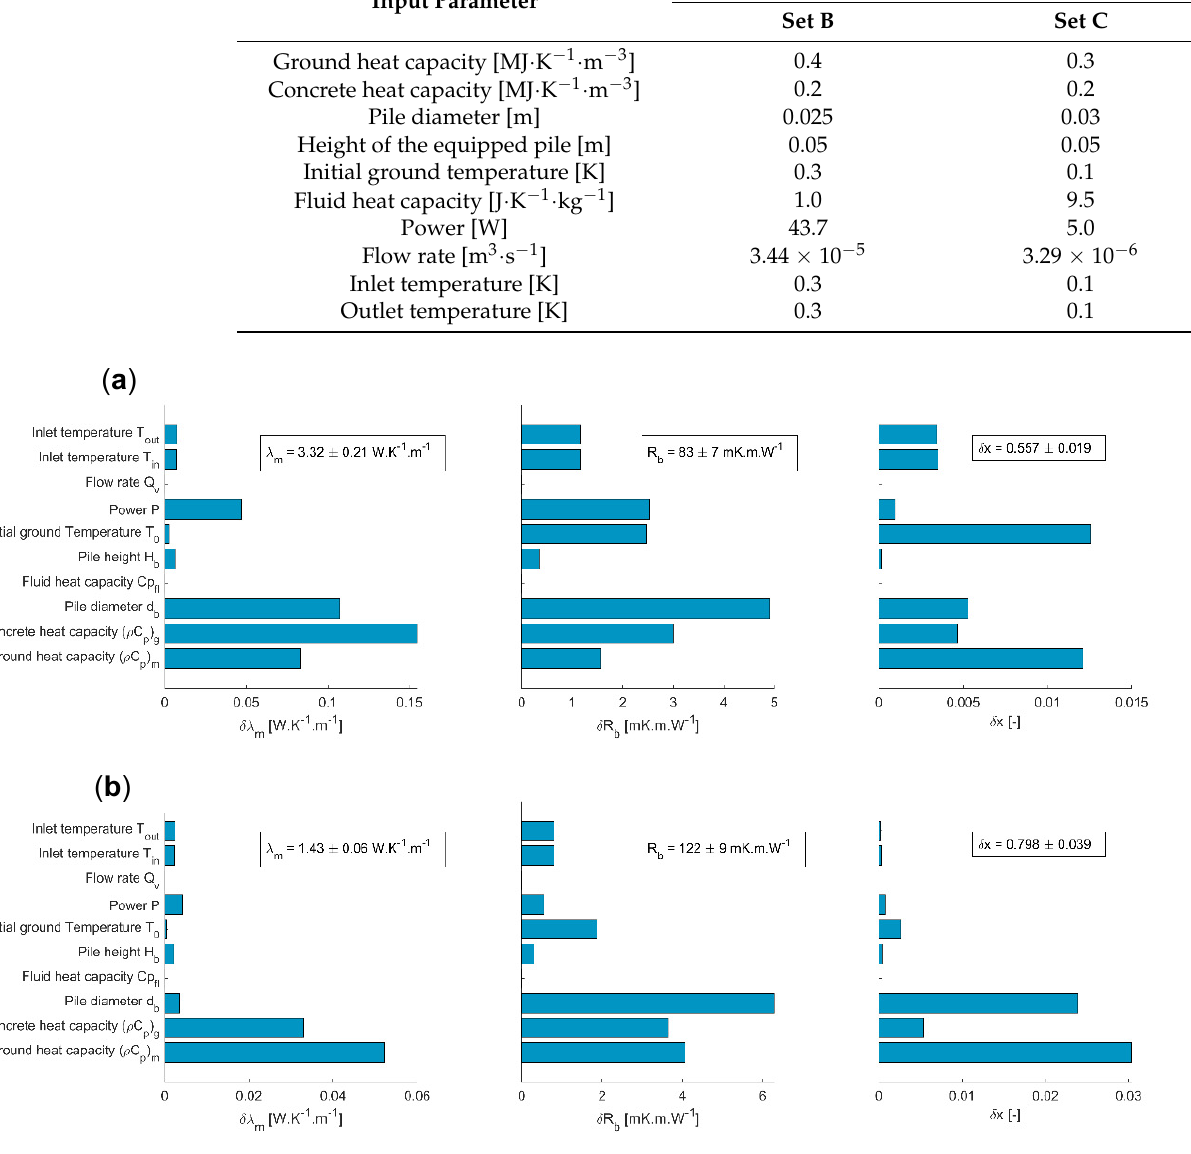
Figure 8. Sources of error (terms